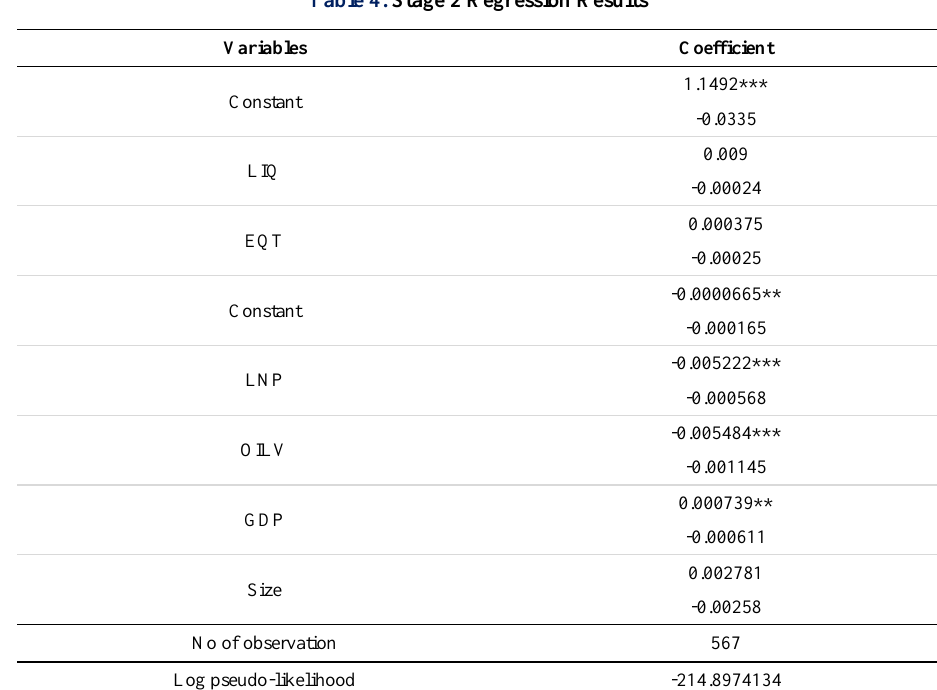
Figure 5. Yearly GCC Banking average efficiency, 2008-2016. Table 4. Stage 2 Regression